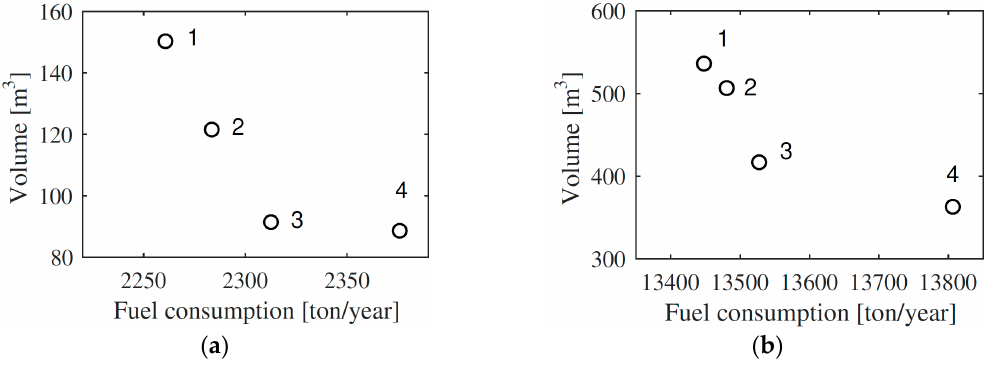
Figure 6. Results of the multi-objective optimization: ( a ) cargo ship; ( b ) cruise ship. The installed machinery configuration, indicated by numbers, is provided in Table 11.